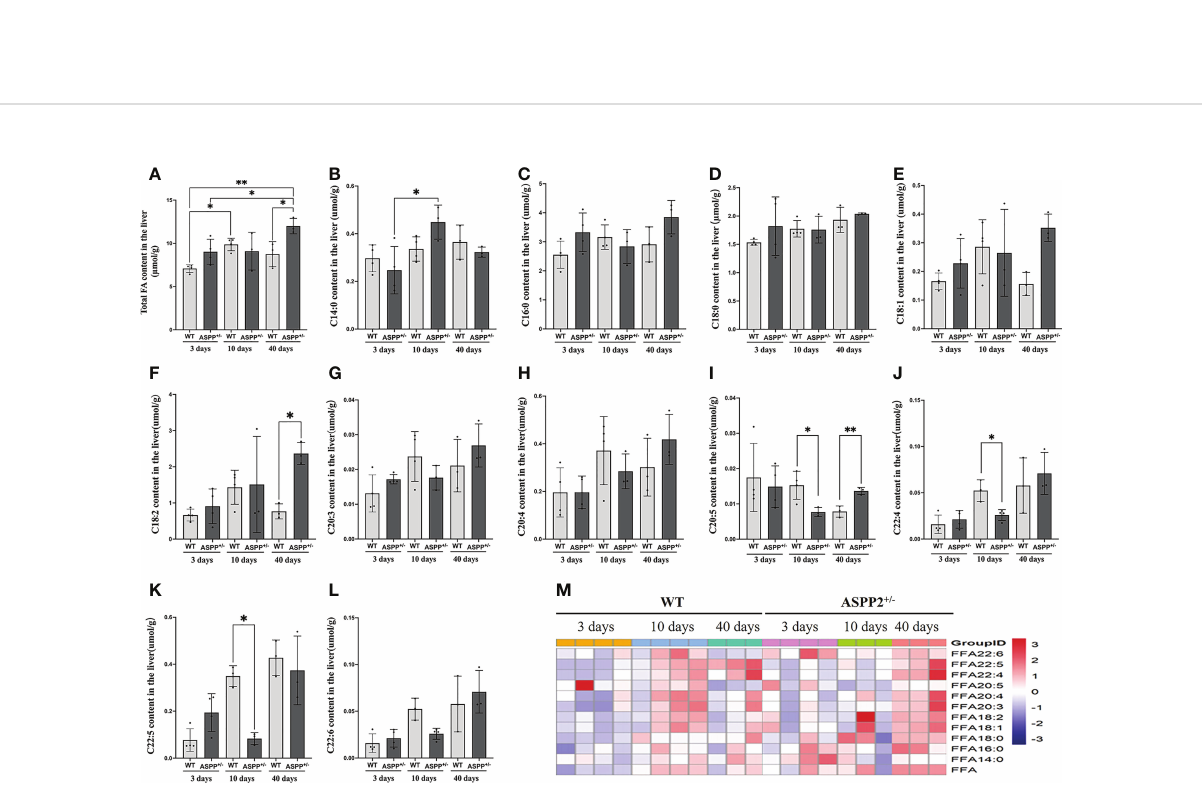
FIGURE 3 Effect of ASPP2 knockout on FFA metabolism. (A) Total fatty acid levels at days 3, 10 and 40 in WT and ASPP2 +/- mice groups induced by MCD diet. (B – M) The levels of C14:0, C16:0, C:18:0, C18:1, C18:2, C20:3, C20:4, C22:4, C22:5 and C22:6 content at days 3, 10 and 40 in WT and ASPP2 +/- mice groups induced by MCD diet. WT-MCD, n = 3-4; ASPP2 +/ – MCD, n =3-4. *p < 0.05; **p<0.01.